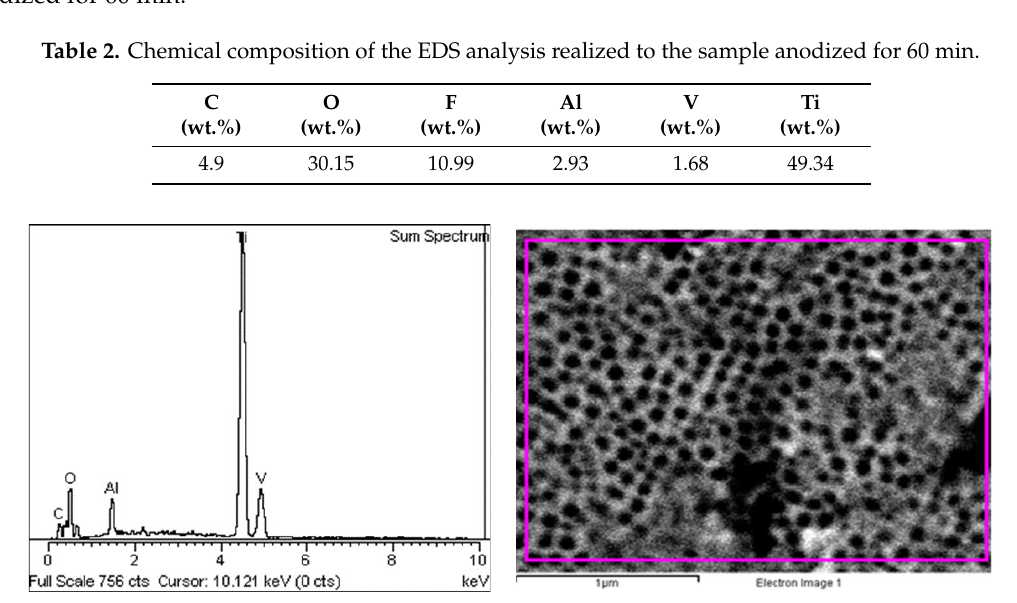
Figure 7. EDS patterns realized to the sample anodized for 60 min. Table 2. Chemical composition of the EDS analysis realized to the sample anodized for 60 min.